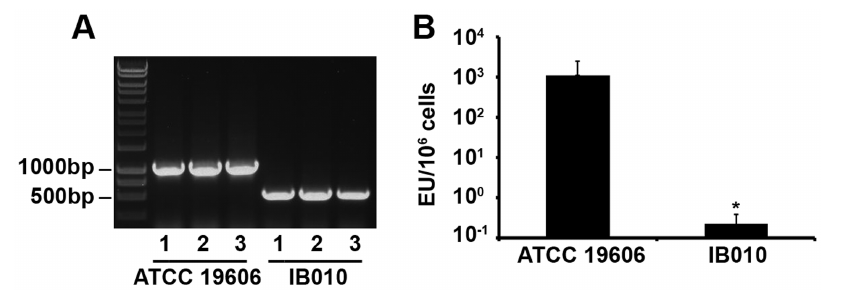
Figure 1. Mutation and endotoxin content of IB010. (A) Genomic DNA from three independent cultures of ATCC 19606 and IB010 was extracted and amplified using primers specific for the lpxD gene. The band corresponding to approximately 1000 Kb corresponds to the intact lpxD gene, whereas the faster migrating band corresponds to the lpx D gene with a deletion of 462 nucleotides. (B) Endotoxin levels of ATCC 19606 and IB010 determined by the Limulus Amebocyte Assay. Bars represent the median values of three independent cultures, and error bars represent the standard error of the mean. EU; endotoxin